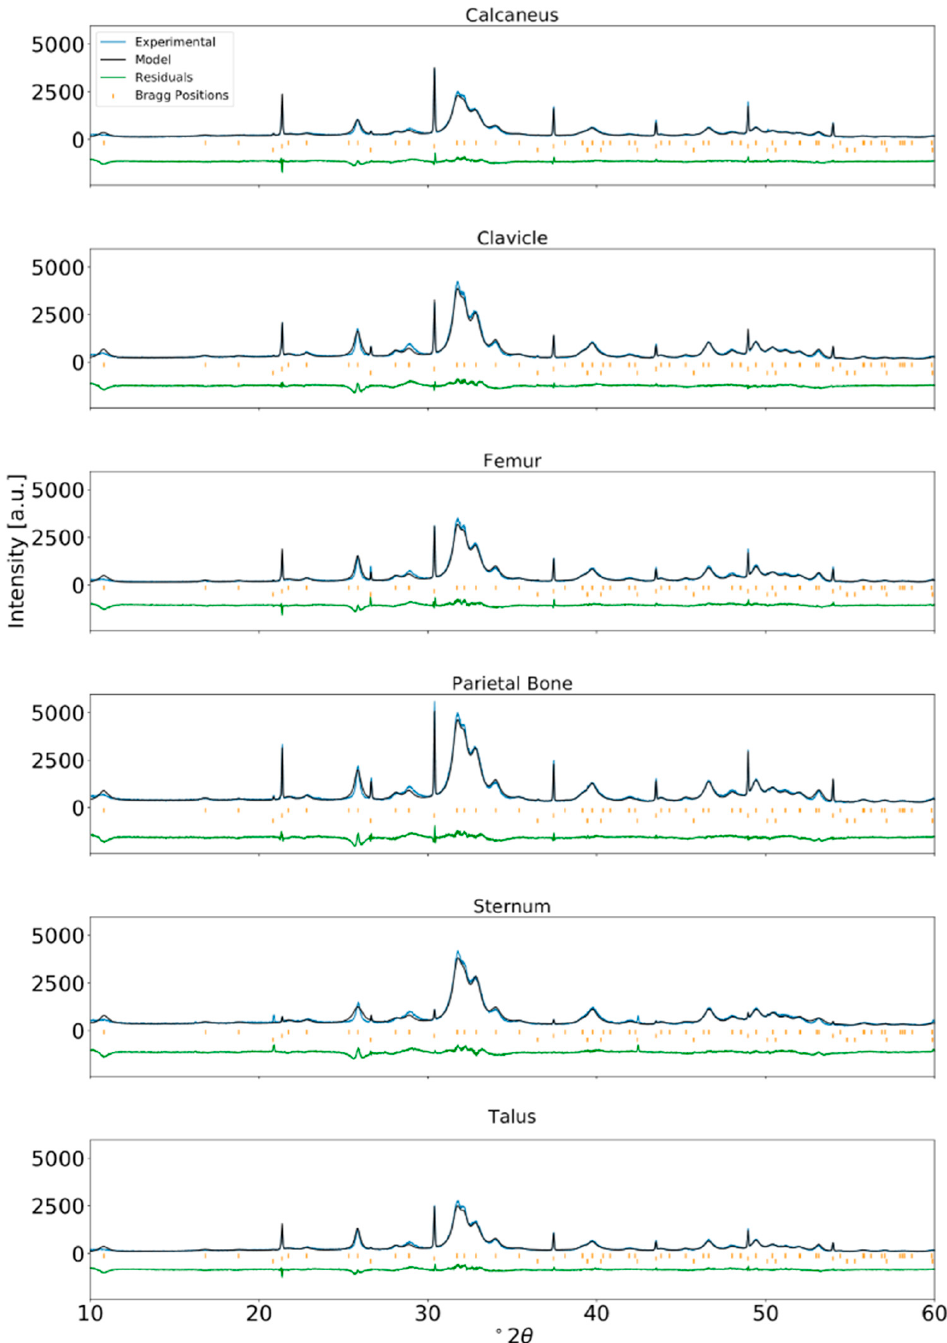
Figure A4. Rietveld refinement of XRPD data for human bone from a PBF adult and internal standard NIST LaB 6 incorporated at approximately 2 wt% ( λ = Cu-K α 1 ).